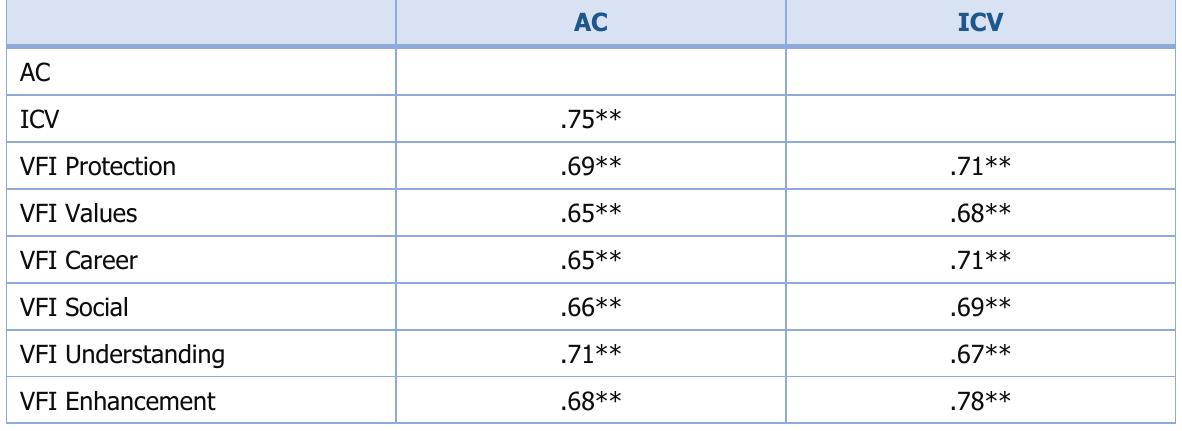
Table 3. Correlations of Participants’ Motivations and Retention as Measured by Affective Commitment (AC) and Intention to Continue Volunteering